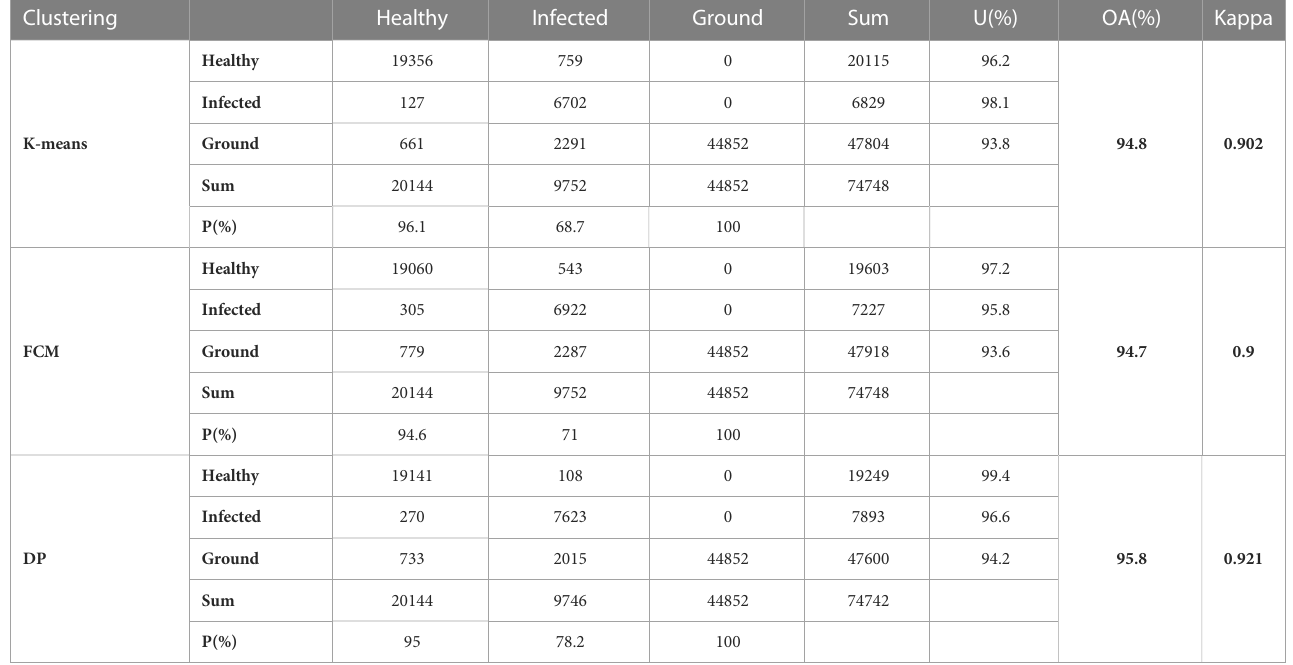
TABLE 4 Accuracy evaluation of the recognition results of different clustering methods. Clustering